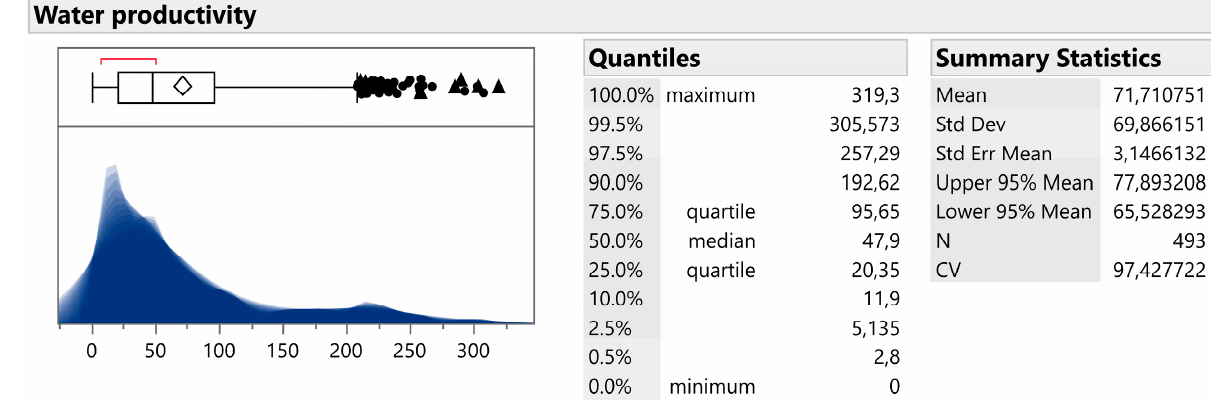
Figure 7. Distribution analysis of the index results: water productivity in 1994–2017 in EU member states with Luxemburg excluded .